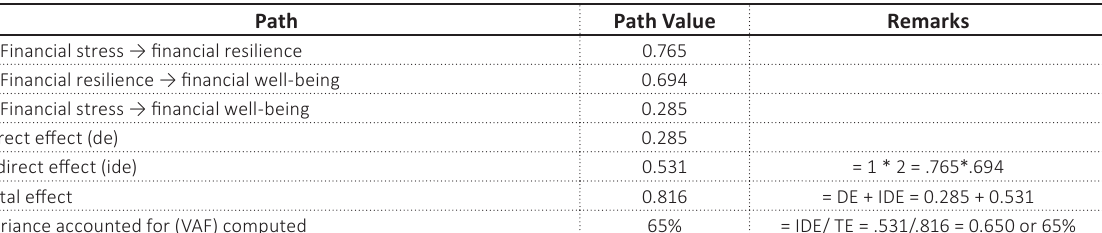
Source: Analysis of survey